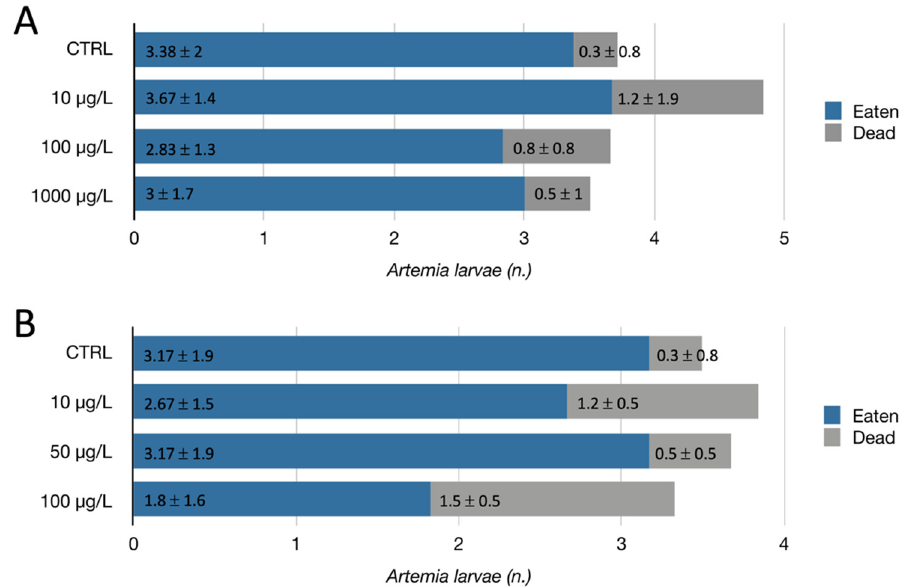
Figure 4. Evaluation of predation ability of H. vulgaris after 7 days of exposure to ( A ) AgNPcitLcys and ( B ) AgNO 3 . The graphs show the average number ( ± standard deviation) of A. franciscana larvae either eaten (blue) or found dead at the bottom of the well (gray).